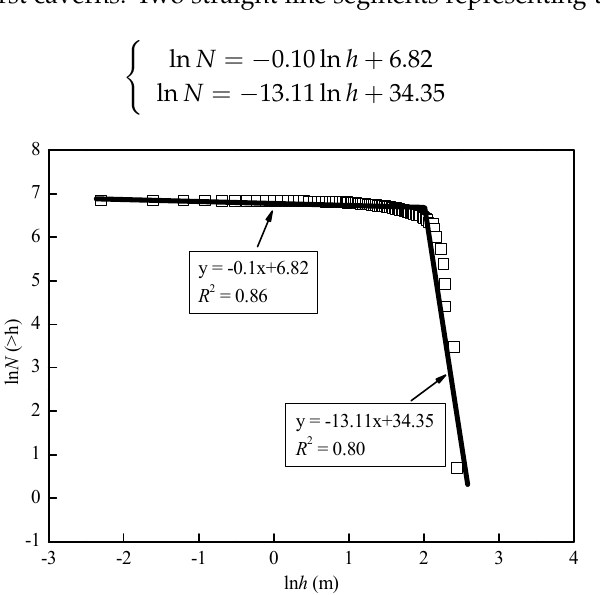
Figure 11. Fractal model describing the relationship between the 937 grouting holes and the diameters of the karst caverns.